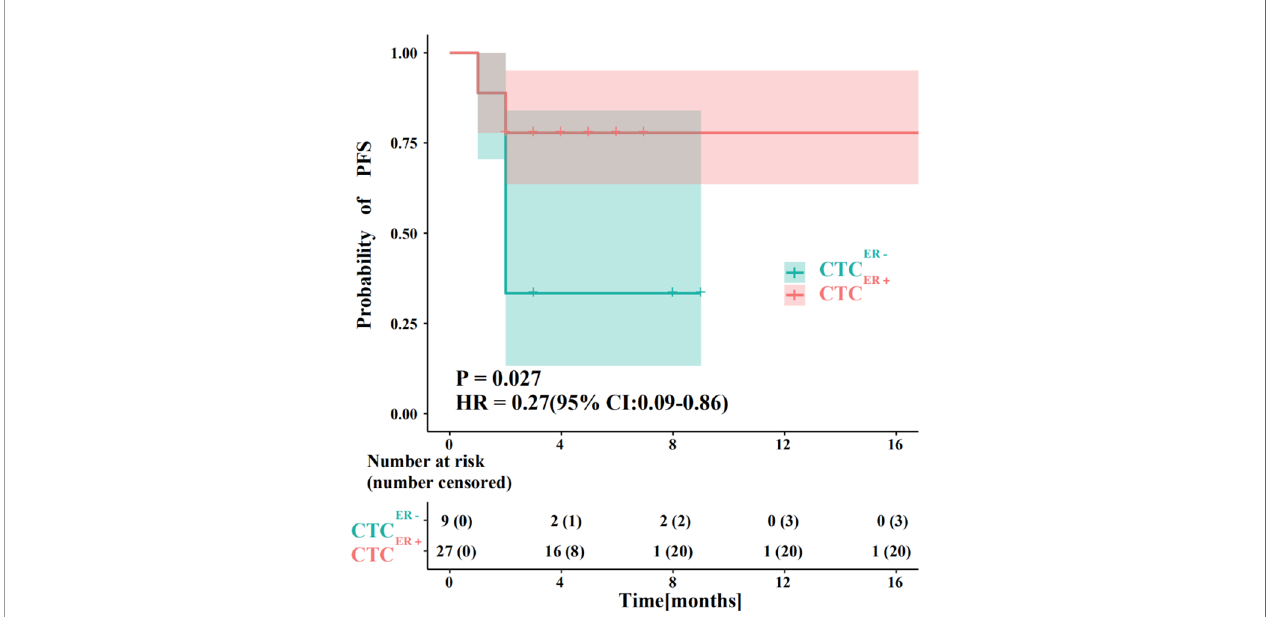
FIGURE 4 | Evaluation of prognostic responses of ER status in CTCs and corresponding IHC results to endocrine therapy. The PFS between BC patients with ER- positive CTCs and those with ER-negative CTCs.